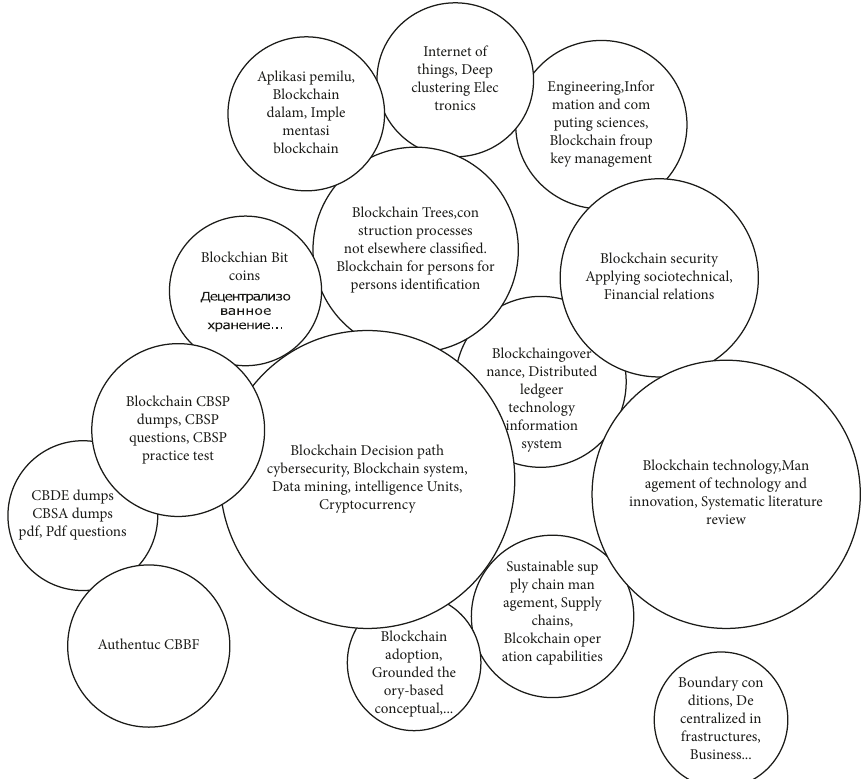
Figure 2: Overview of research on blockchain. Source: Open Knowledge Maps (2022). Overview of research on blockchain. Retrieved from https://openknowledgemaps.org/map/5f73499253c87dec9f0a22736f1bcf0b (2 Mar